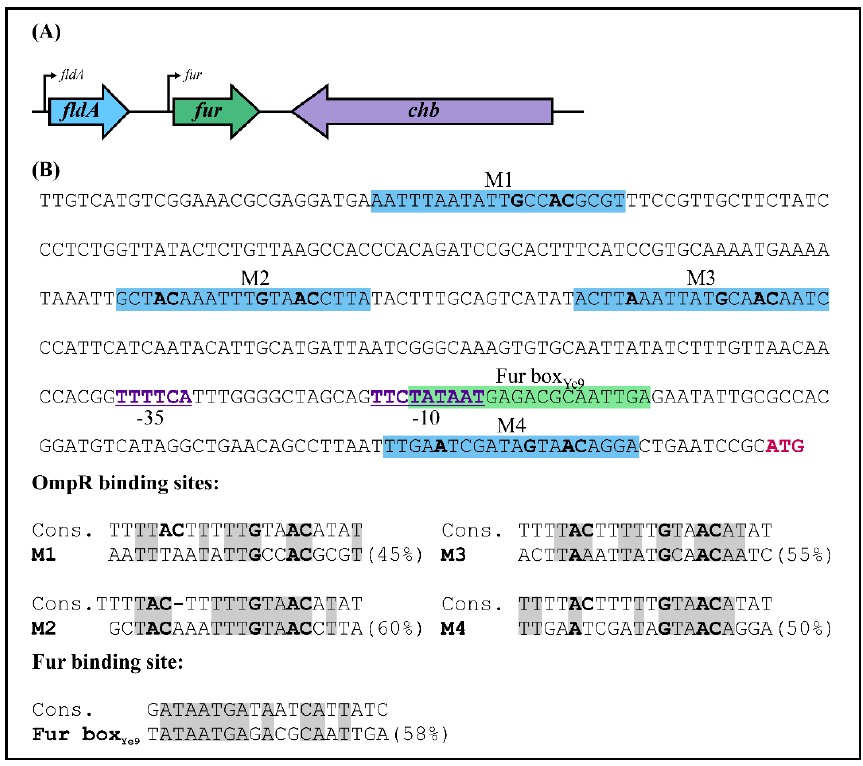
Figure 1. Chromosomal organization of the Y. enterocolitica fur locus. ( A ) Genes comprising the Y. enterocolitica fur locus. The directions of transcription are indicated by arrows. The encoded products are: fur —Fur (ferric uptake regulator); fldA —flavodoxin I; chb —chitobiase. ( B ) The fur promoter region of Y. enterocolitica Ye9N. The nucleotide sequence from − 368 to +3 nt relative to the first nucleotide of the fur ATG start codon (colored pink) is shown. The − 10 and − 35 motifs of the fur promoter are marked purple, bold and underlined. The putative OmpR-binding sites (M1, M2, M3, M4) are highlighted by a blue background, while the potential Fur-binding site (Fur box Ye9 ) is highlighted by a green background. The putative OmpR- and Fur-binding sites are shown aligned to the E. coli consensus sequences (% identity values are shown). Identical nucleotides in the compared sequences are shaded gray. In both the promoter region sequence and alignments, nucleotides important for OmpR binding are in